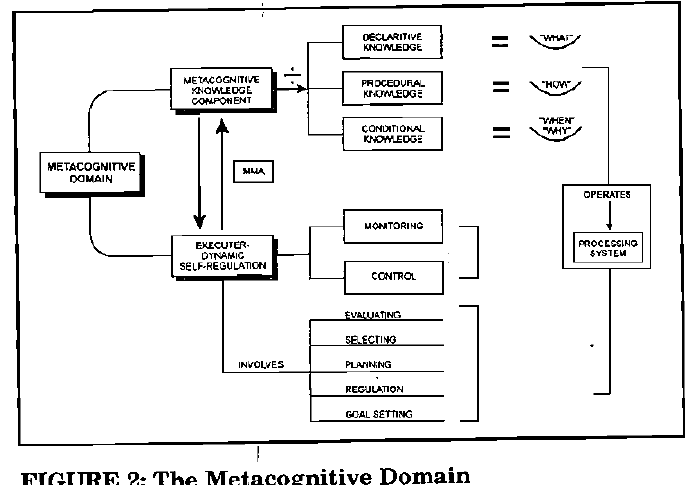
FIGURE 2: The Metacognitive